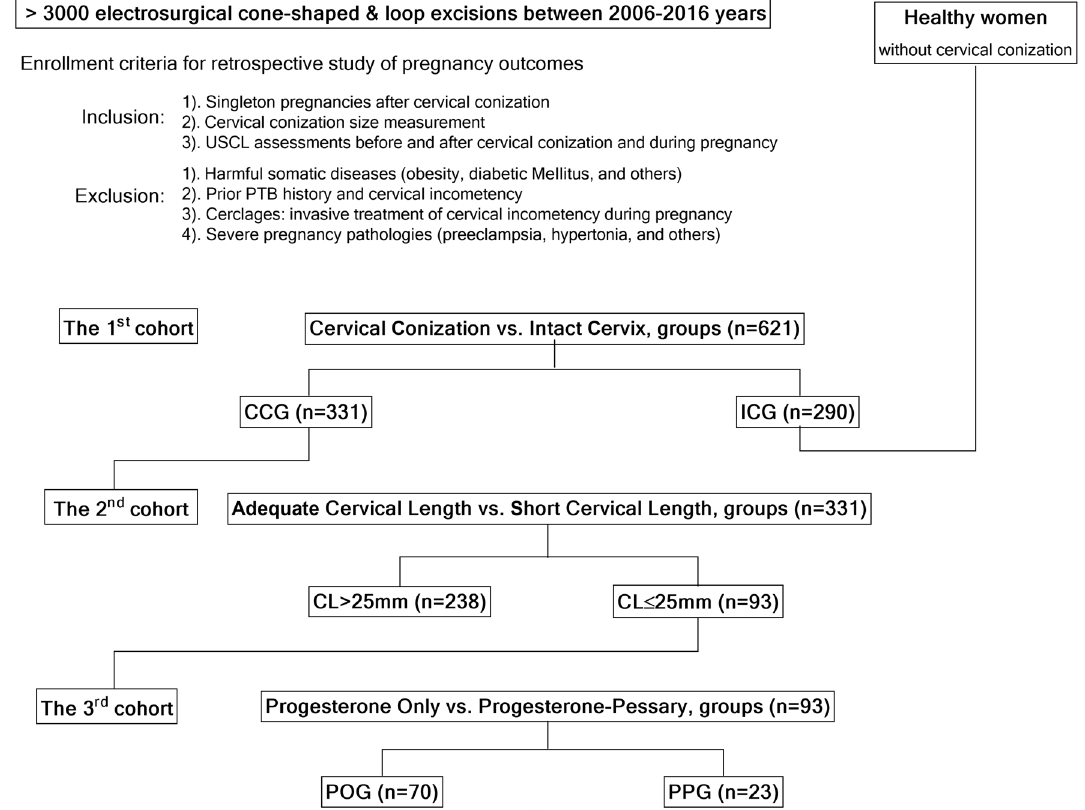
Figure 1. A flowchart of cervical conization impact on pregnancy outcome. PTB preterm birth, USCL ultrasound cervical length, CCG cervical conization group, ICG intact cervix group, CL > 25 mm adequate cervical length group, CL ≤ 25 mm short cervix group, POG Progesterone-only group, PPG Progesterone- Pessary